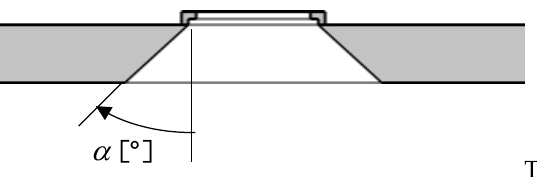
Figure 6. A cross-section through the roof window showing the inclination (slanting; α ) of the window lining.